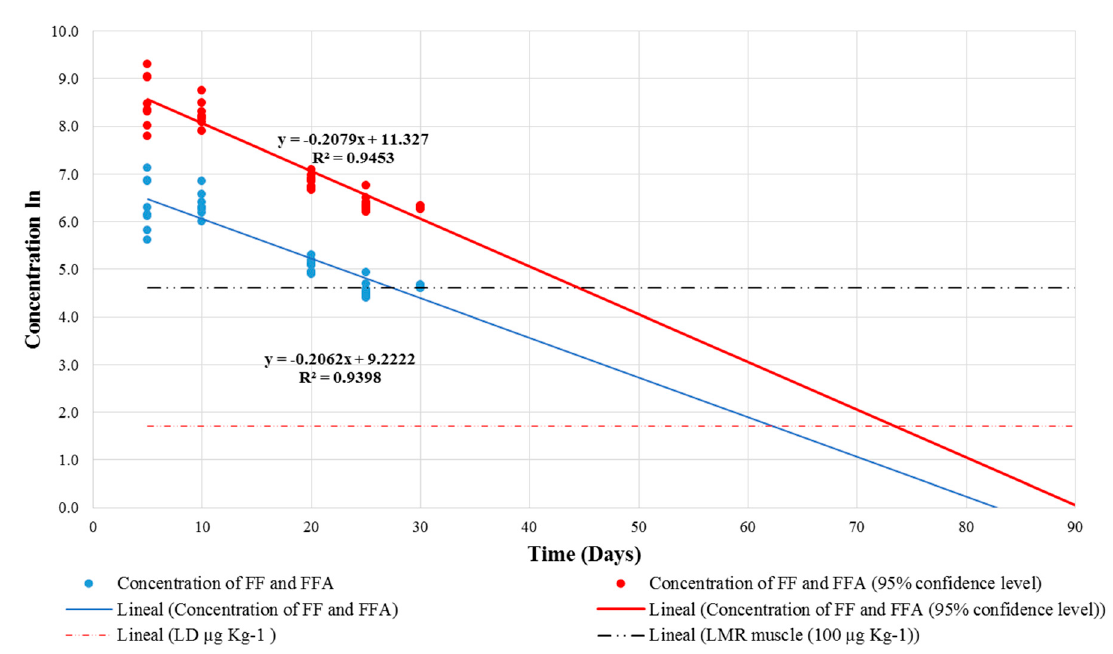
Figure 2 . Depletion of FF and FFA residue concentrations in broiler chicken claws (95% confidence level), showing a withdrawal time of 74 days.